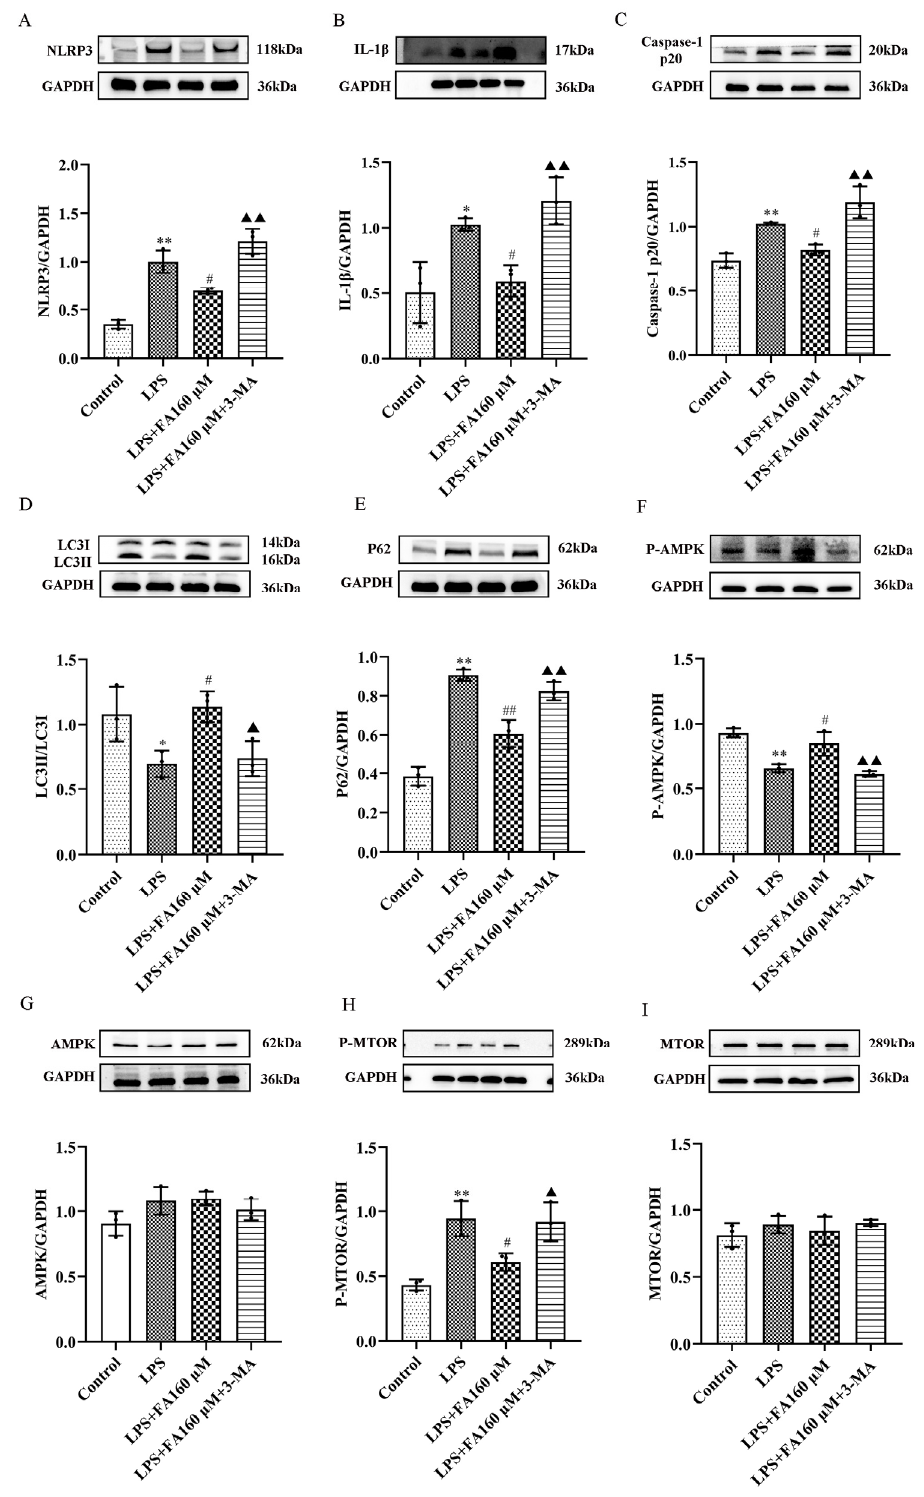
Figure 6. Autophagy inhibitors (3-MA) undermine all beneficial effects of FA. ( A – I ) NLRP3, IL-1 β and caspase-1 p20 were detected by Western blot. Autophagy-related proteins LC3 and P62 and pathway proteins P-AMPK/GAPDH, AMPK/GAPDH, P-mTOR/GAPDH and mTOR/GAPDH were expressed. Data are means ± standard deviations (SDs) ( n = 3). ** p < 0.01, * p < 0.05, vs. control; ## p < 0.01, # p < 0.05, vs. LPS; ▲▲ p ＜ 0.01, ▲ p ＜ 0.05 vs. FA + LPS.